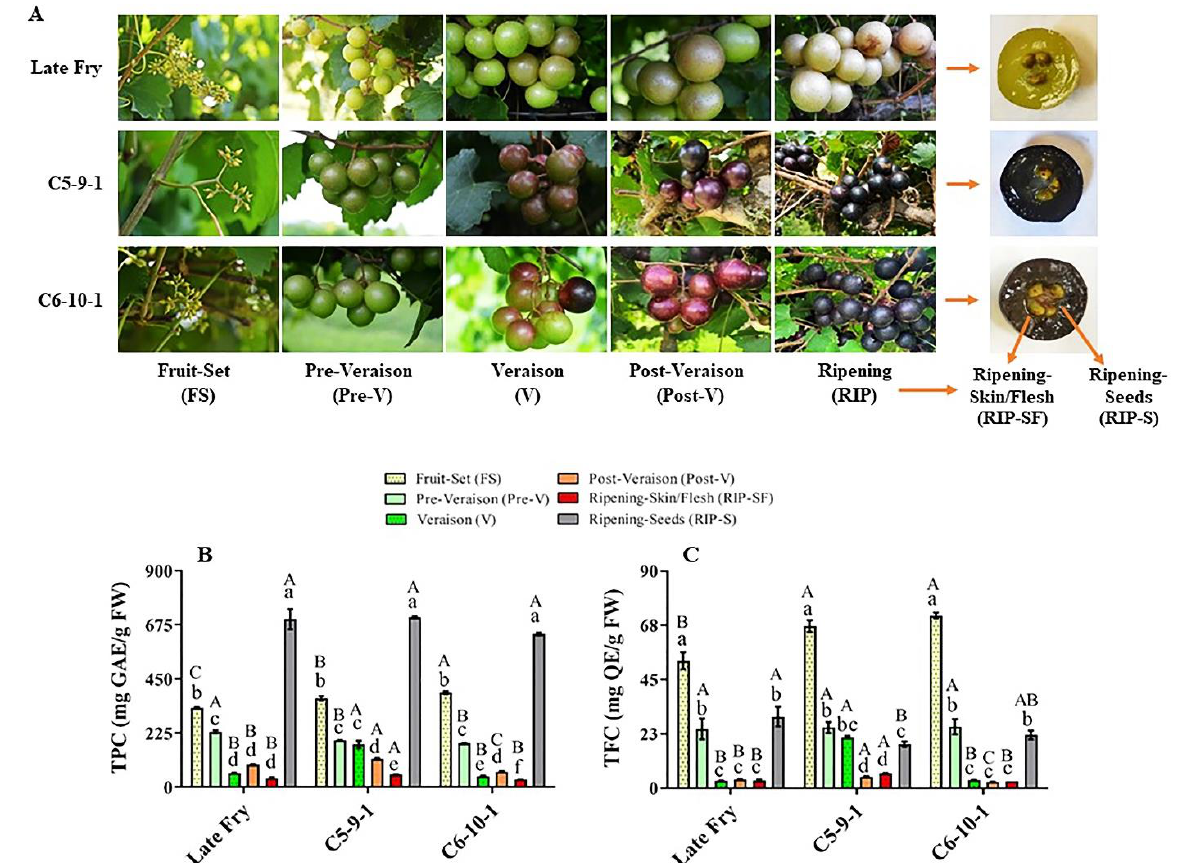
Figure 1. ( A ) A representative image of muscadine grape genotypes Late Fry, C5-9-1, and C6-10-1 during developmental stages. The developmental stages include fruit-set (FS), pre-veraison (pre-V), veraison (V), post-veraison (post-V), and ripening (RIP). The ripening stage was separated into skin/flesh (RIP-SF) and seeds (RIP-S). Accumulation of ( B ) total phenolic content (TPC) and ( C ) total flavonoid content (TFC) of muscadine grape genotypes at different developmental stages. Colors representing each developmental stage are indicated. The experiments were carried out in three biological replicates, and each replicate was repeated three times ( n = 9). Data represent the mean values ± SD ( n = 3). The different lowercase letters represent the significant differences among developmental stages of an individual genotype, and the different uppercase letters refer to the significant differences between genotypes of a particular developmental stage, according to Duncan’s multiple-range test ( p > 0.05).